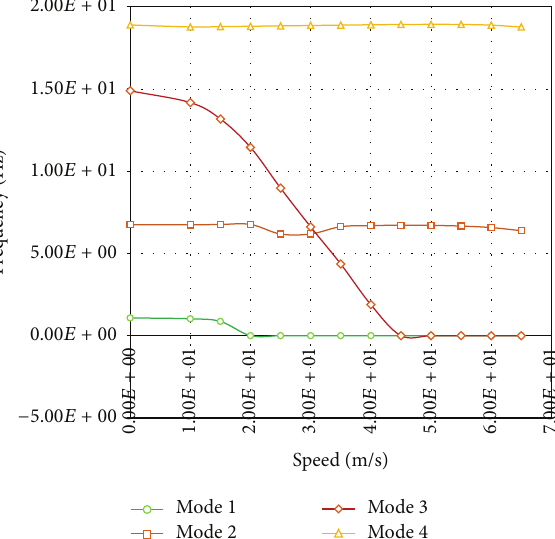
Figure 7: 𝑉 - 𝑔 plot of the rectangular plate.